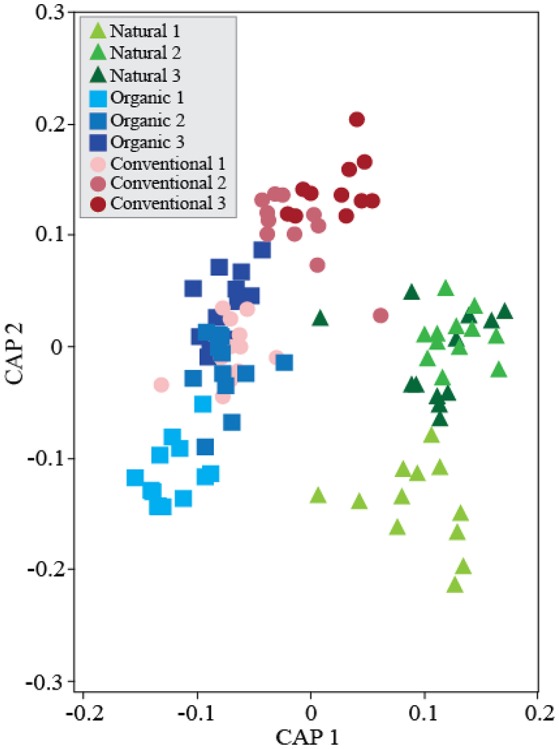
Temporal shifts of soil bacterial communities across soil management regimes. Canonical Analyses of Principal Coordinates based on constrained ordination by soil management*time. First axis δ2 = 0.91 and second axis δ2 = 0.89. TraceQ_m'HQ_m statistic: 4.28*** (***P < 0.001). Soil samples were collected every 30 days for community composition assessments. This analysis did not include treatment effects in the constrained ordination.